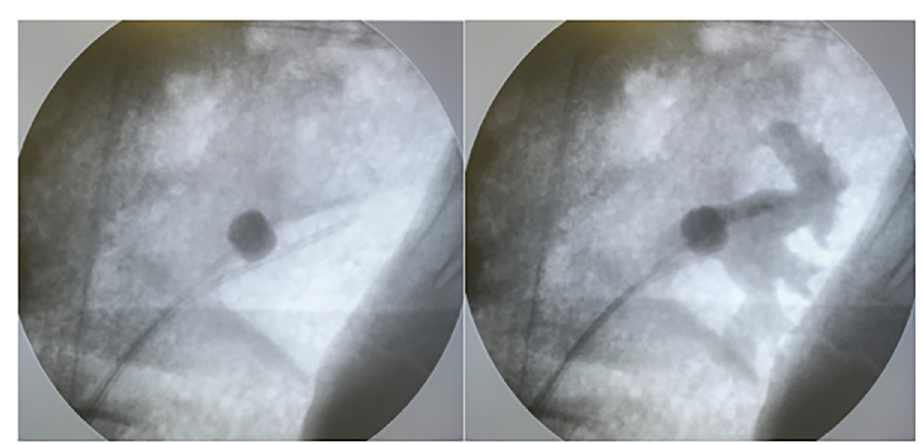
Fig 1. Pyelography. Placement of ureteral catheter and balloon catheter for occlusion, irrigation and pressure measurement confirmed by fluoroscopic